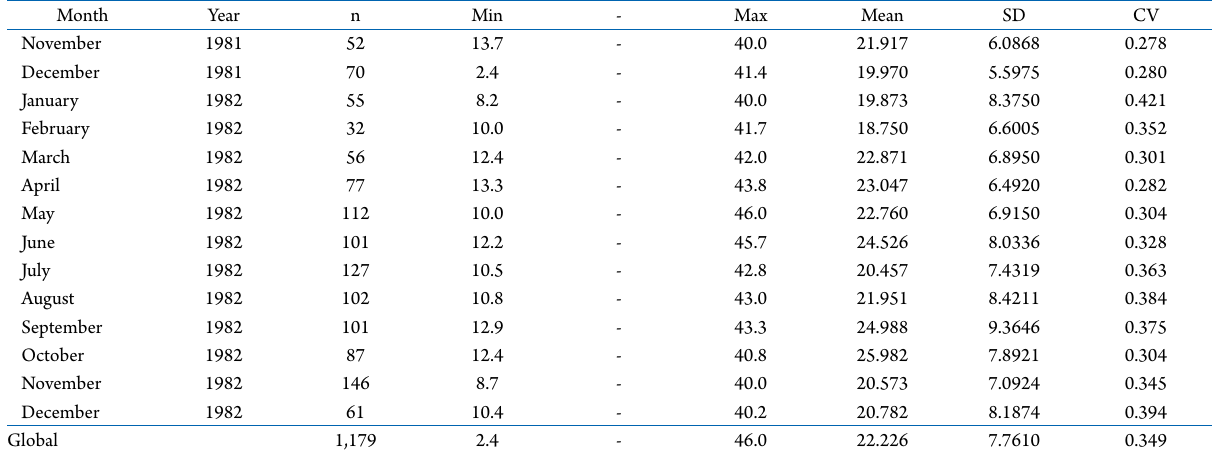
Table 1. Cephalotorax length (CL) monthly average (mm) of the Parastacus nicoleti specimens.